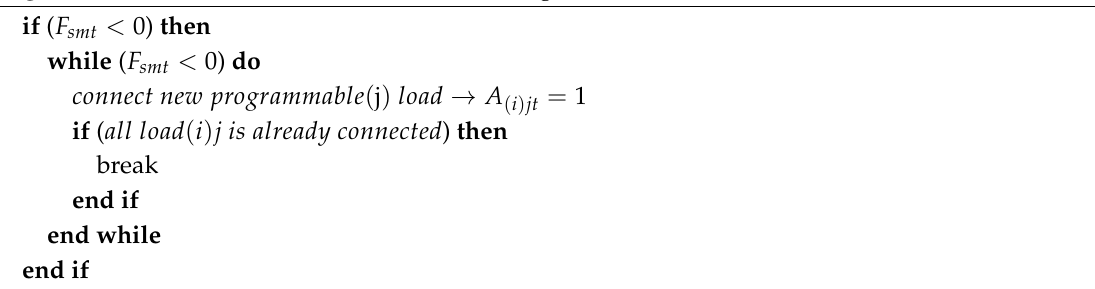
Algorithm 2 Minimize function F smt in the smart grid ( t = 1